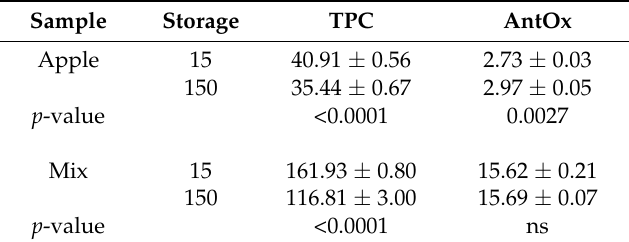
Table 3. Total phenolics content (TPC-mg GAE/100 mL) and antioxidant capacity (AntOx-mg GAE/100 mL) of apple- and mix-RCW drinks after 15 and 150 days of